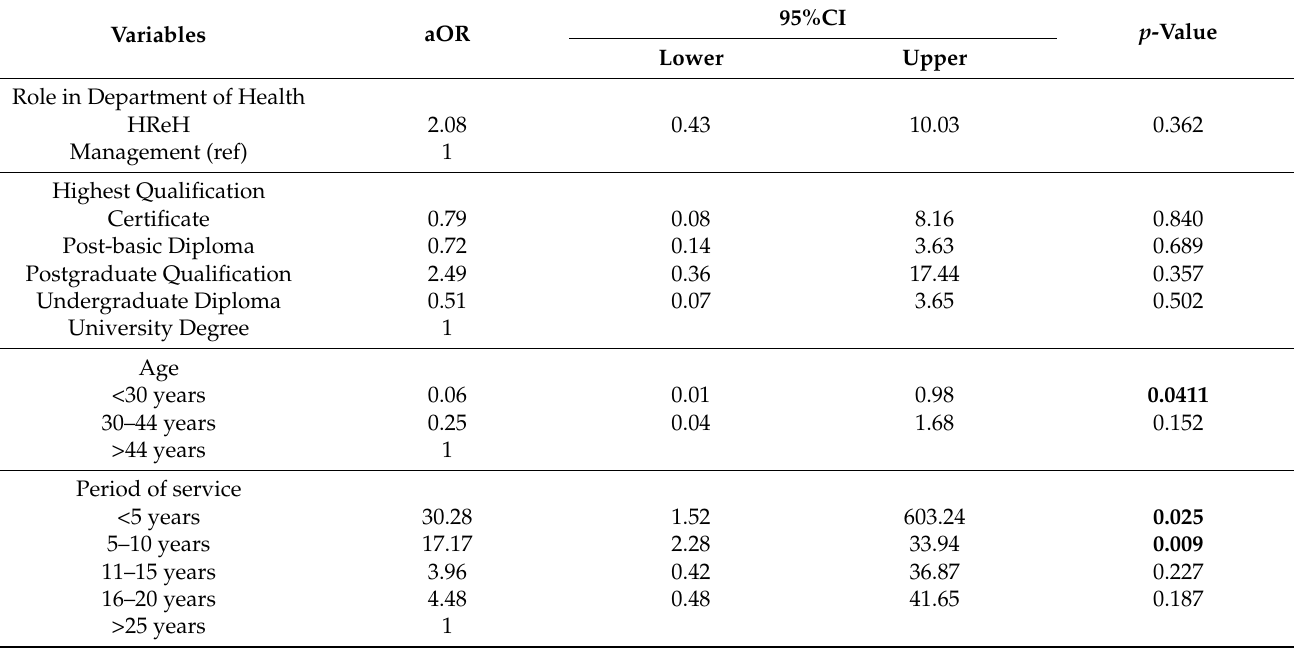
Table 4. Association between attitude and demographic